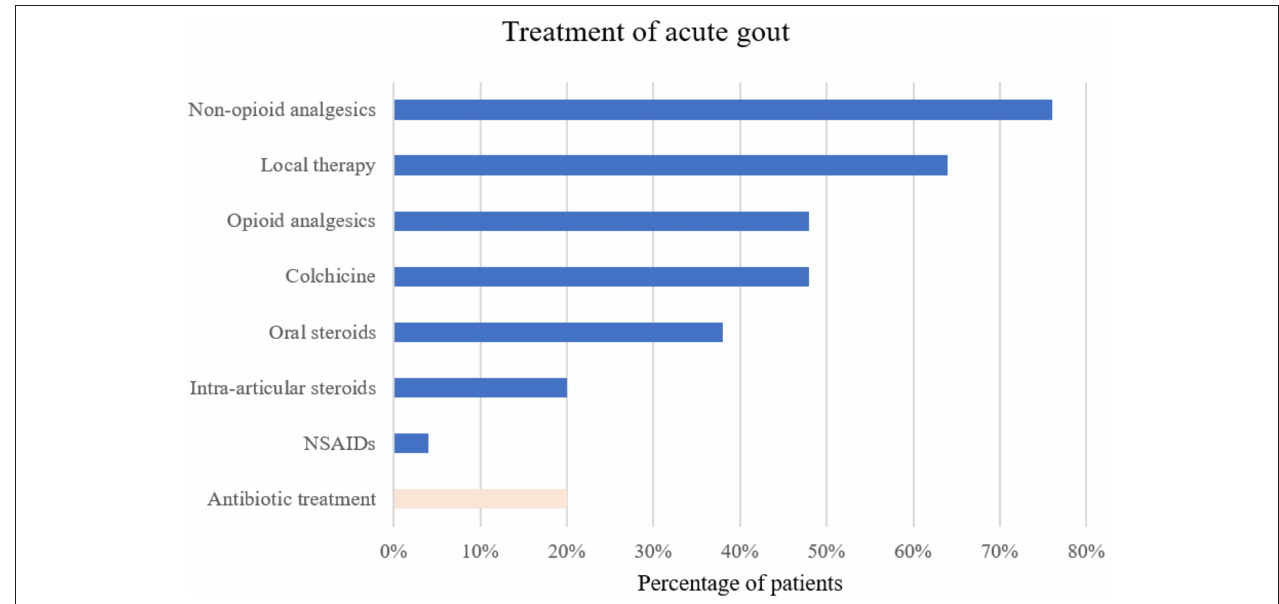
FIGURE 4 | Treatment of the acute gout episode in percentage of patients receiving the therapy. NSAIDs, non-steroidal anti-inflammatory drugs.